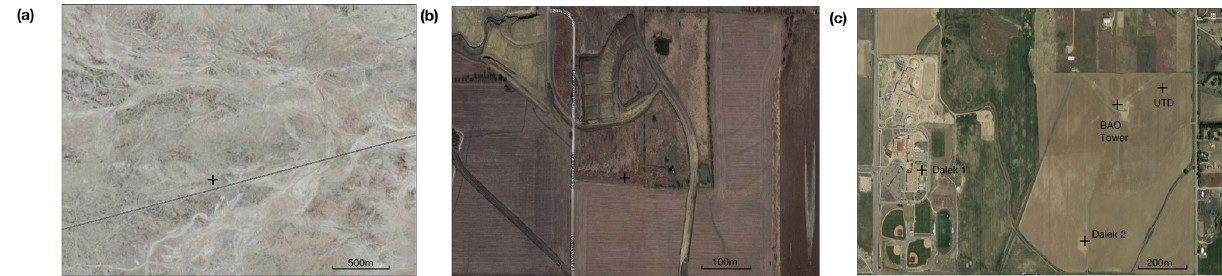
Figure 2. Aerial views of the test sites: (a) SLTEST facility; (b) Celina site; and (c) XPIA campaign at the Boulder Atmospheric Observatory. Source © Google Earth. Black crosses represent the instrument locations. In (c) , each lidar is labeled with its respective name.